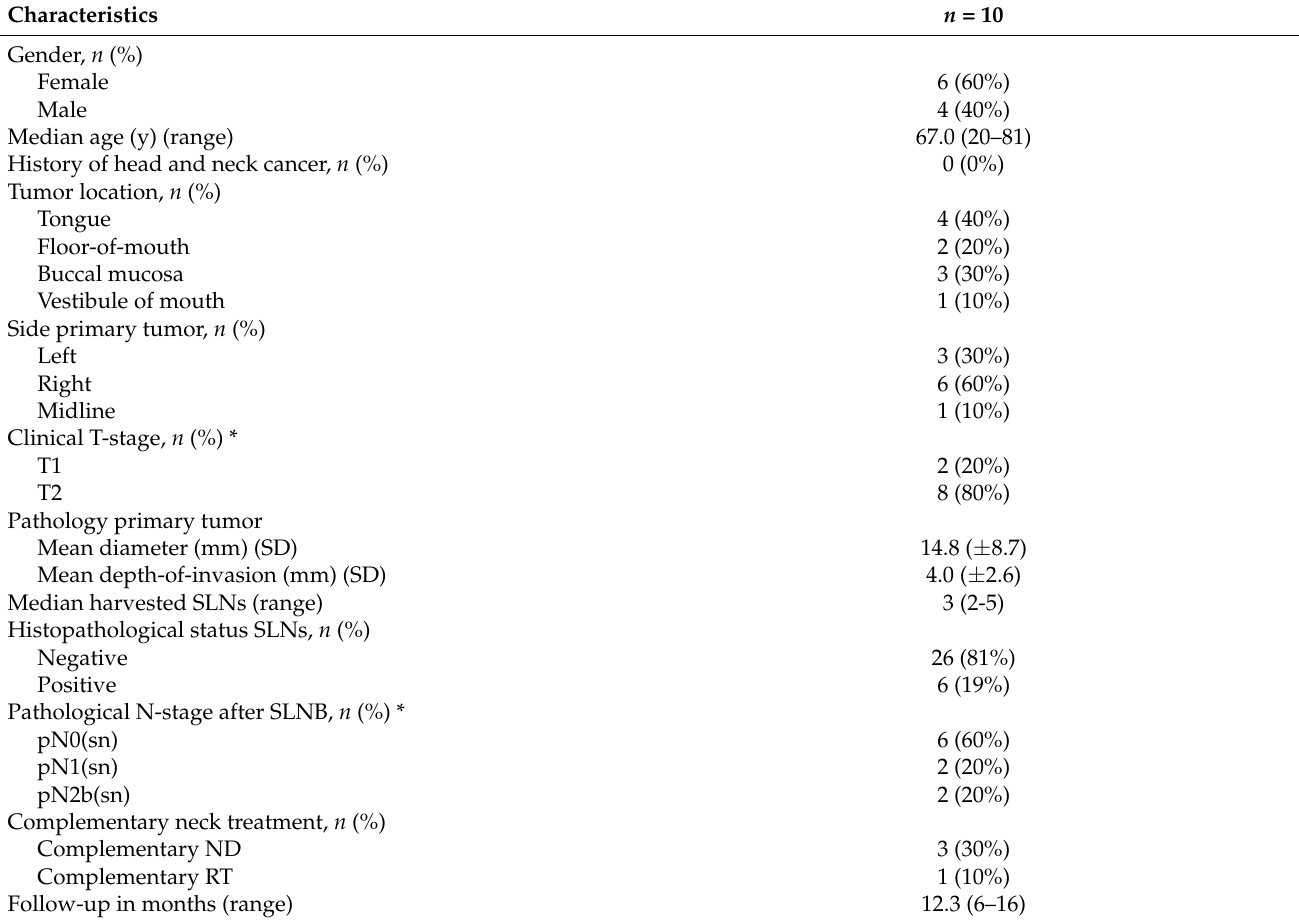
Table 1. Patient- and tumor